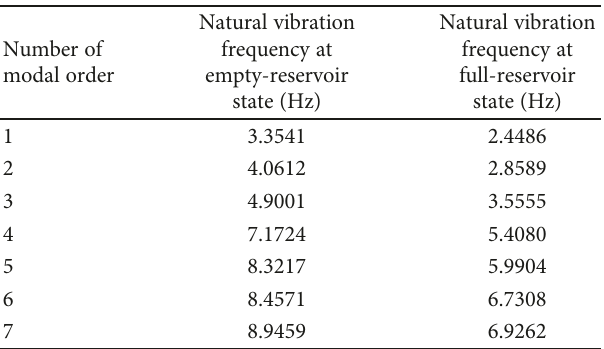
Table 1: Natural vibration frequencies of arch dam under empty- reservoir and full-reservoir